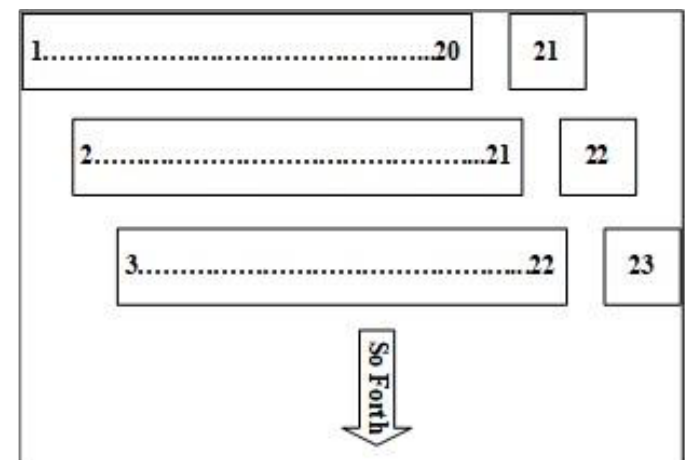
Figure 14. Process of Sliding Window. Table 15. The Value of Each Measure for COVID-19 Period with One-Day-Ahead Forecast.